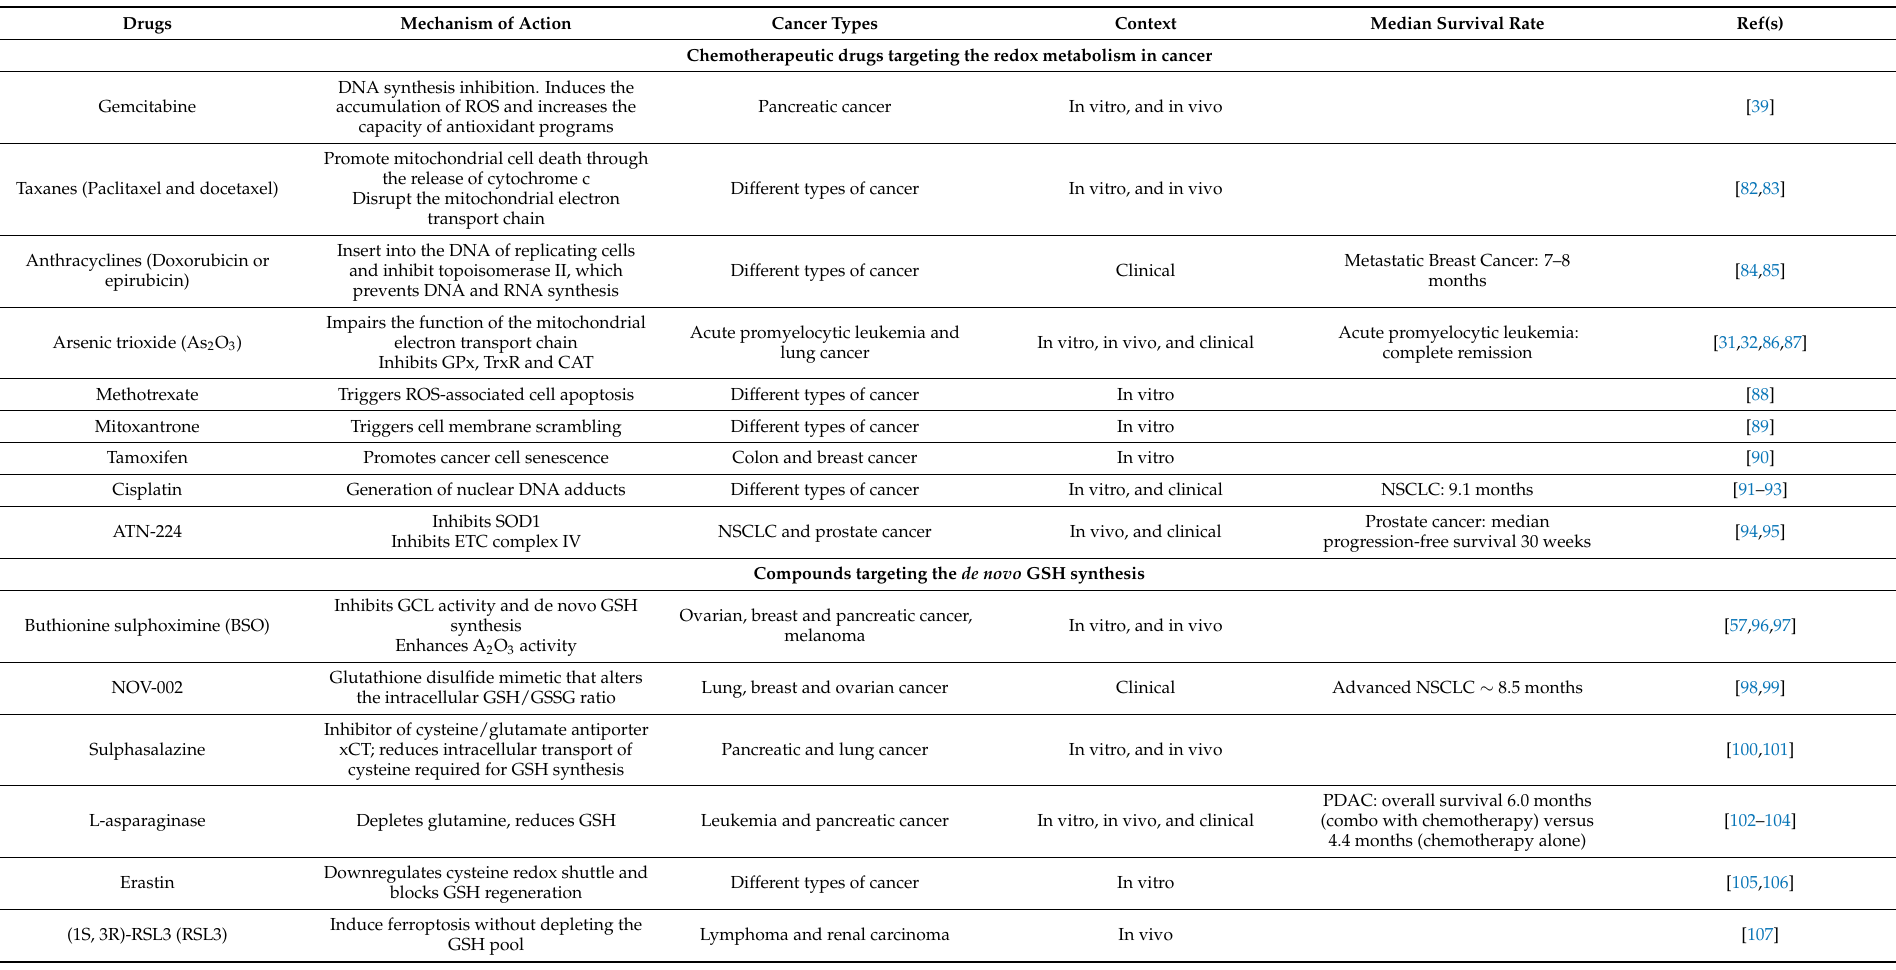
Table 1. Anticancer treatments regulating ROS